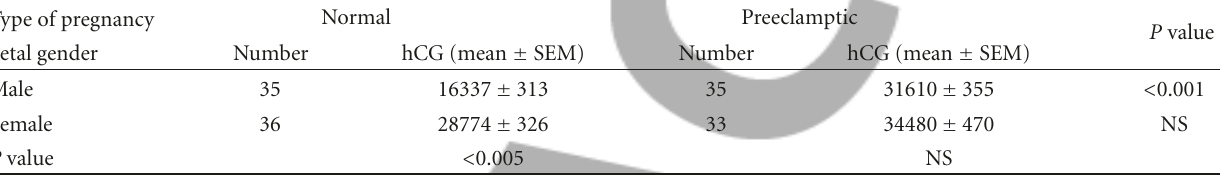
Table 2: Comparison of mean serum hCG level in normal and preeclamptic pregnancies with male and female fetuses. Type of pregnancy